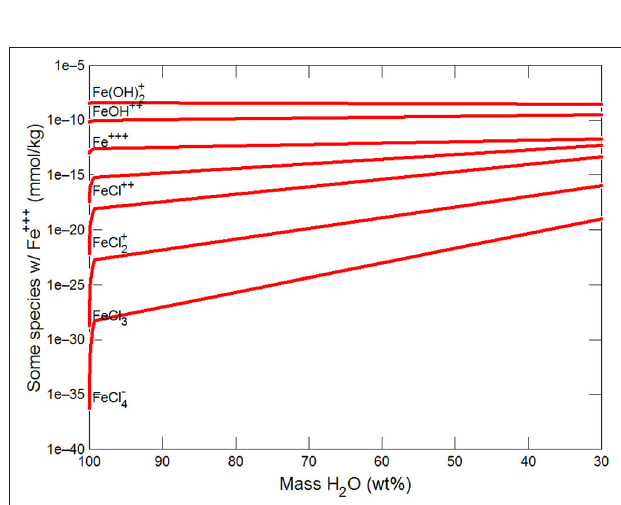
FIGURE 6 | Variations in Fe species during freezing of glacial